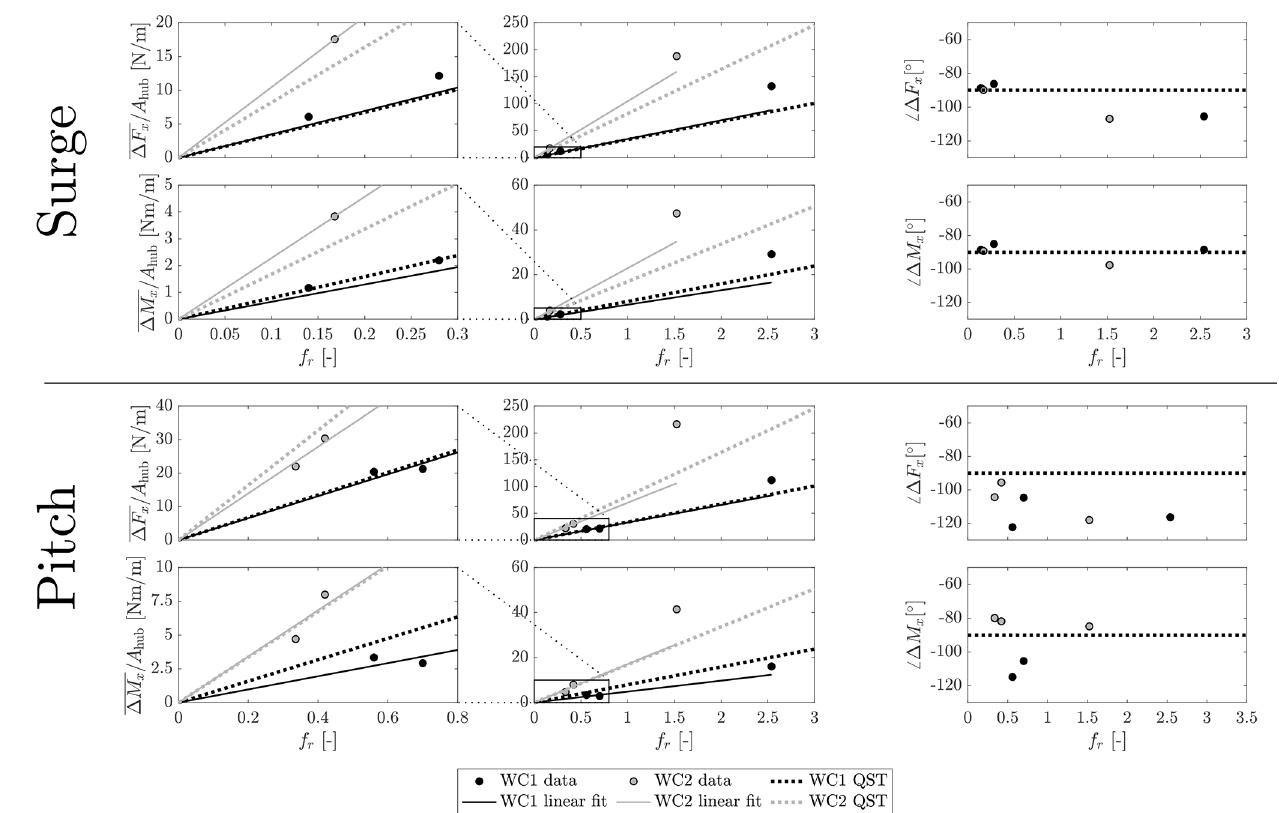
Figure 6. The thrust and torque responses to surge and pitch motion in the two wind conditions of the experiment WC1 and WC2 compared to quasi-steady theory (QST) in terms of normalized zero-peak amplitude and phase shift with respect to platform motion. The linear fit is the least-square linear regression of amplitude data which is obtained excluding the points at the highest reduced frequency and intercepts the axes in the origin; QST is the prediction of the quasi-steady theory model computed from the steady-state thrust and torque coefficient maps of Fig.